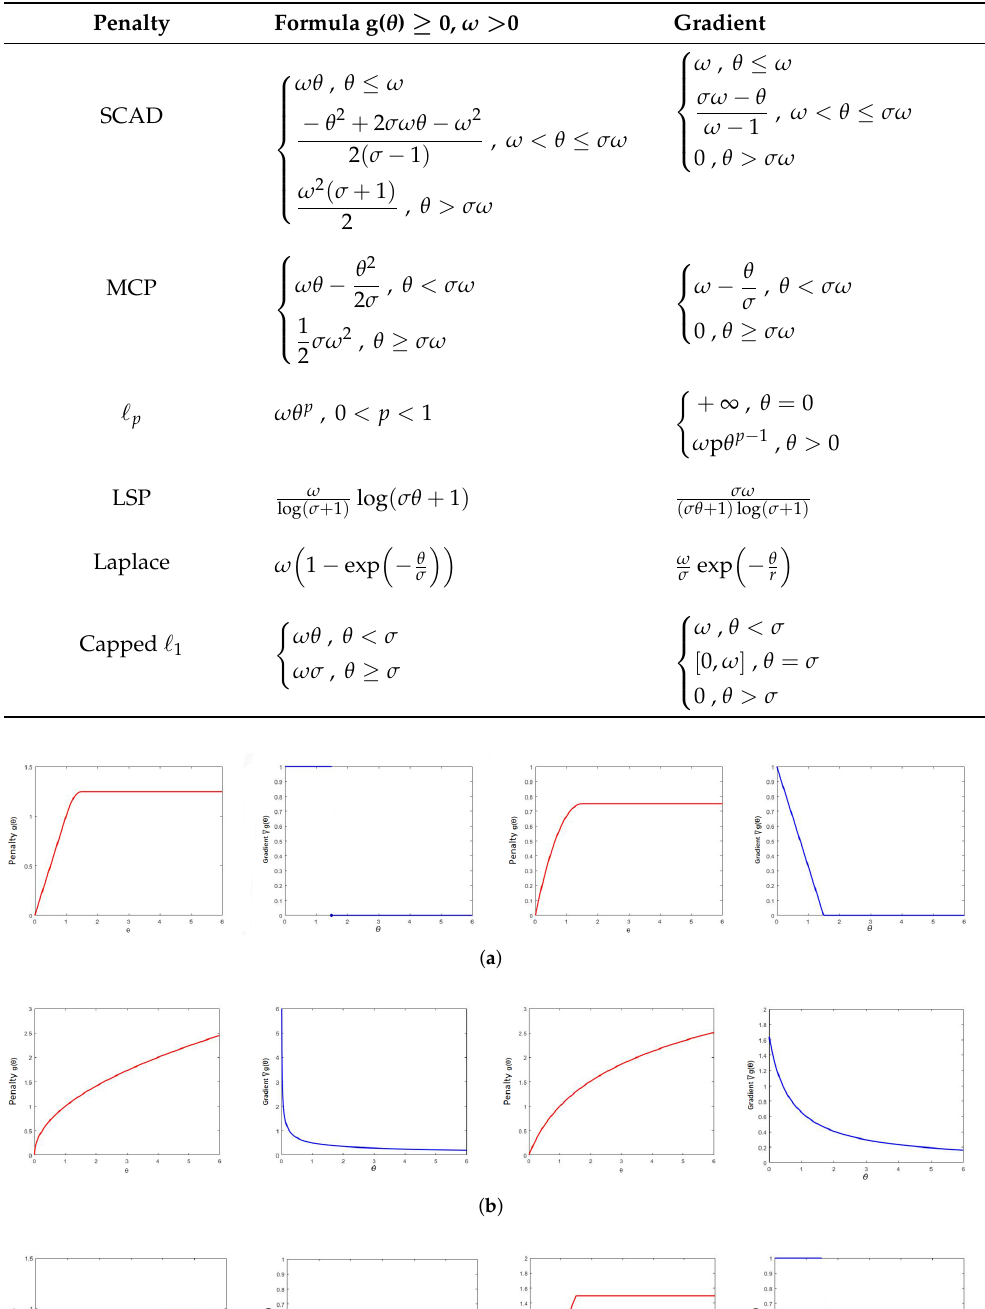
Table 1. Popular nonconvex surrogate functions of (cid:96) 0 operator.